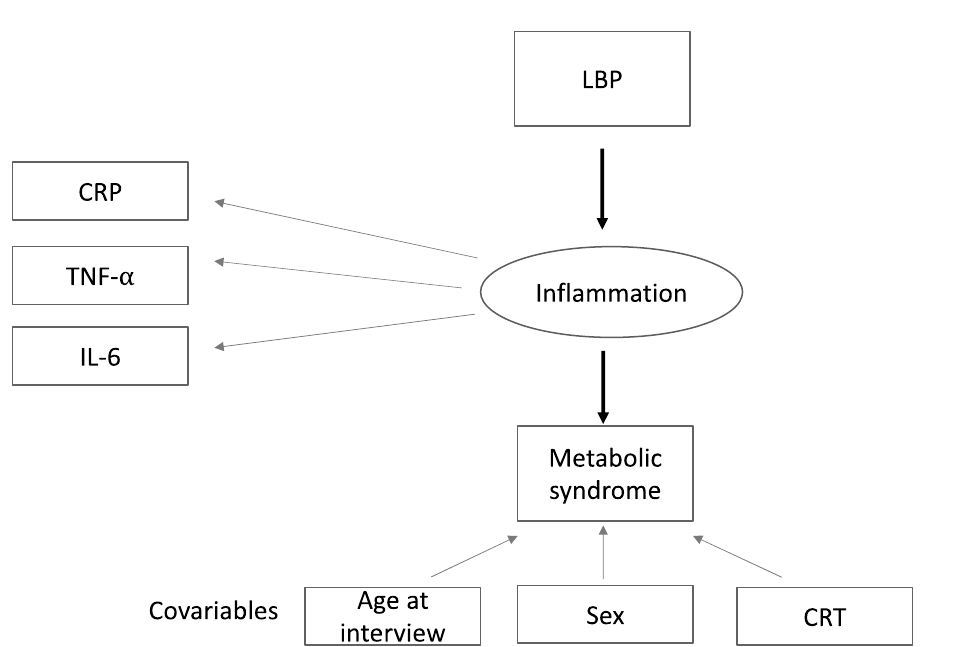
Figure 2. Path diagram corresponding to structural equation model between LBP (biomarker of endotoxemia), inflammation as the latent variable (derived from CRP, TNF-α and IL-6) and metabolic syndrome. The conventional rules of SEM visualization were